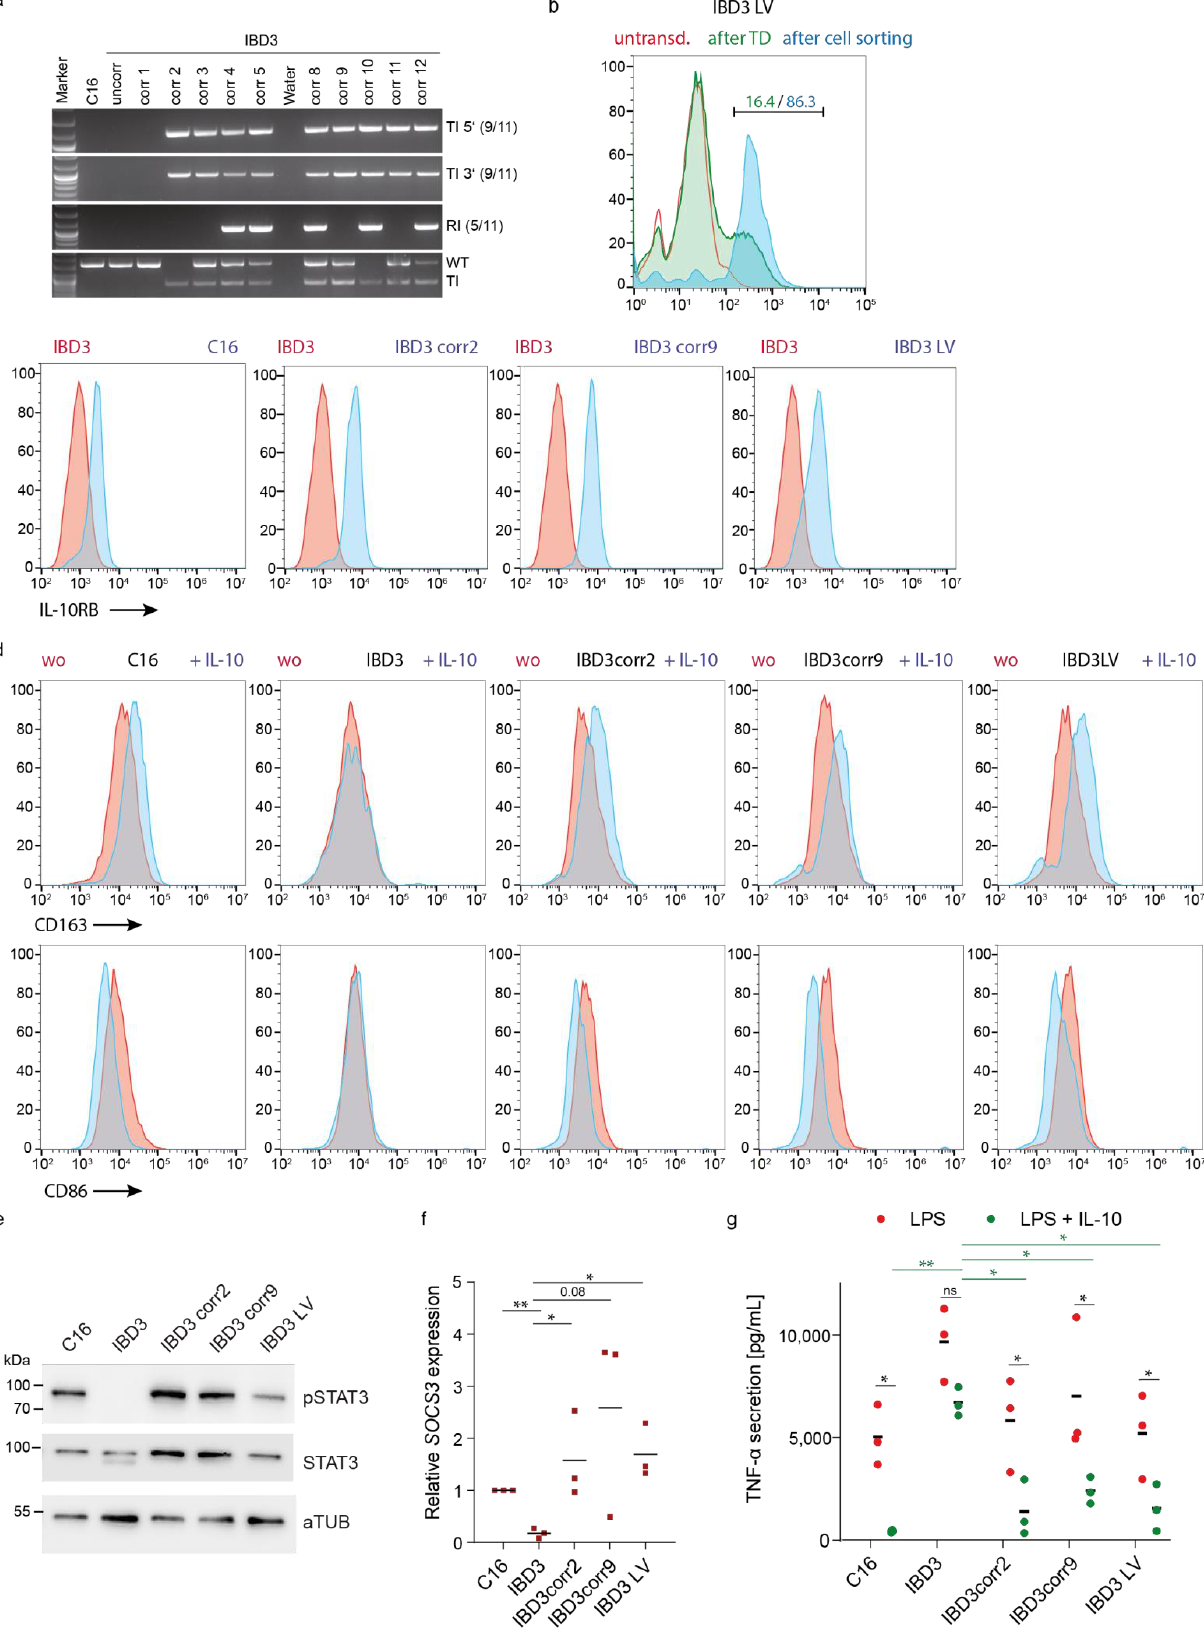
Figure 4. Genetic correction of iPSCs resulted in functional anti-inflammatory recovery of iPSC-derived